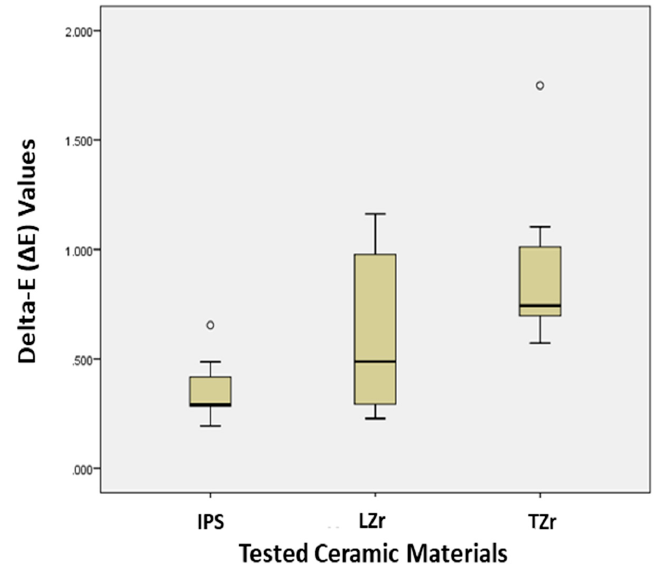
Figure 6. Comparison of color differences demonstrated as Delta E ( ∆ E) values between the three tested materials (IPS, LZr, and TZr).